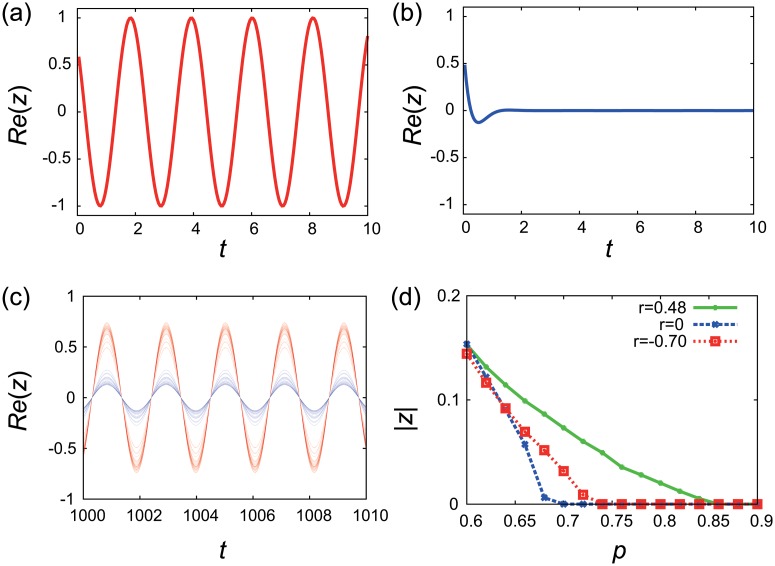
Dynamical robustness of coupled SL oscillator networks.(a) Limit-cycle oscillation produced by the single isolated active oscillator. (b) Damping oscillation produced by the single isolated inactive oscillator. (c) The global oscillatory behavior in an uncorrelated network of active and inactive oscillators. The time evolutions of the state variables of some active (red) and inactive (blue) oscillator nodes are plotted. The parameters are set at N = 3000, p = 0.4, and r = 0. (d) The order parameter |Z| plotted against the fraction p of the inactive oscillators in uncorrelated (r = 0), assortative (r = 0.48), and disassortative (r = −0.7) networks with power-law degree distributions. The correlated networks were generated by the GER method.